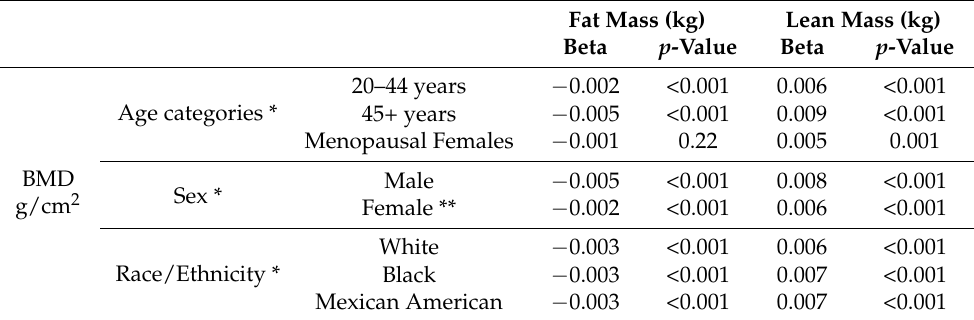
Table 3. Stratified regression analysis models examining the associations between bone mineral density (g/cm 2 ) and fat mass (kg) and lean mass (kg), by sex and age